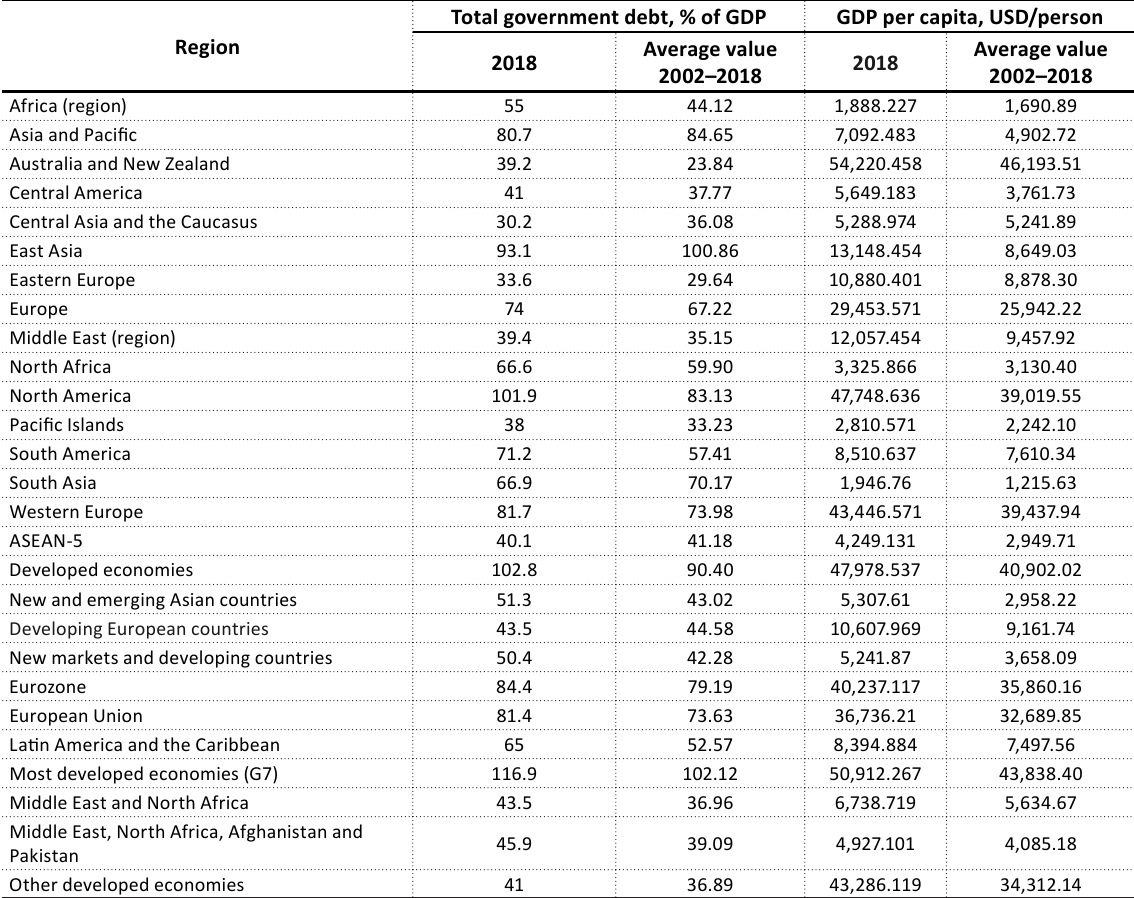
Table 1. The average govermnent debt (% of GDP) and GDP per capita in the regions of the world